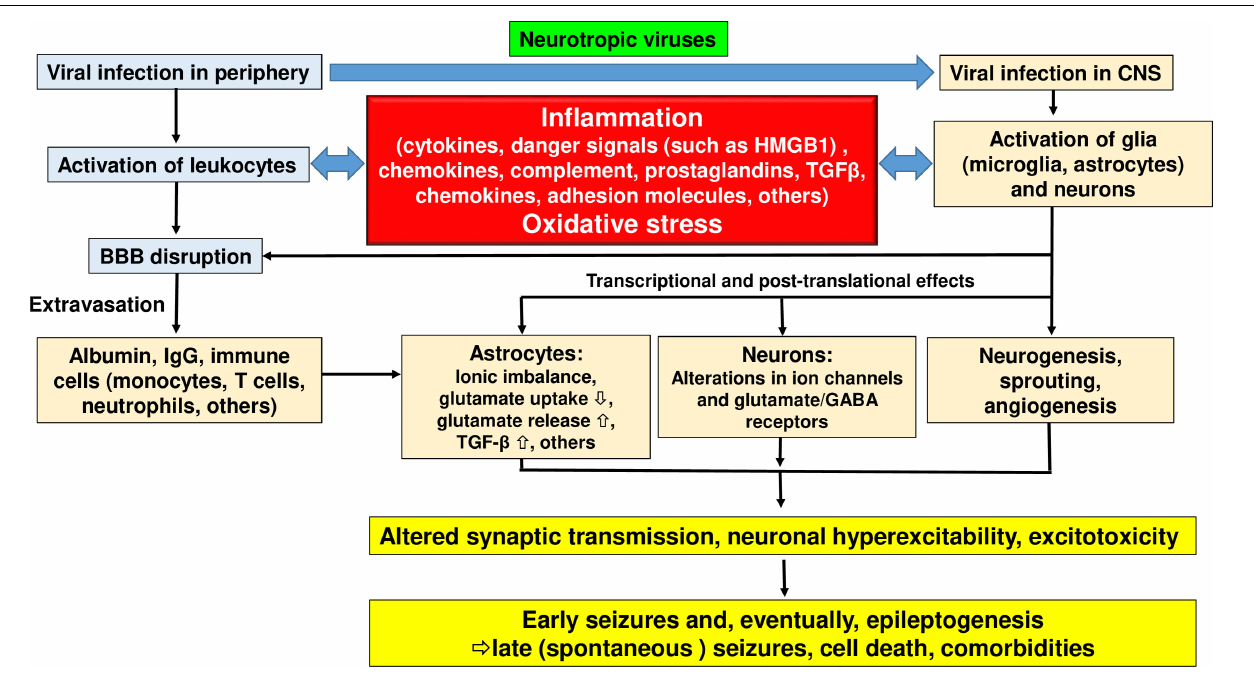
FIGURE 5 | Pathophysiological cascade of events leading from viral infection to inflammation to seizures and epilepsy. See text for details. Modified from Vezzani et al. (2011) and Vezzani et al.